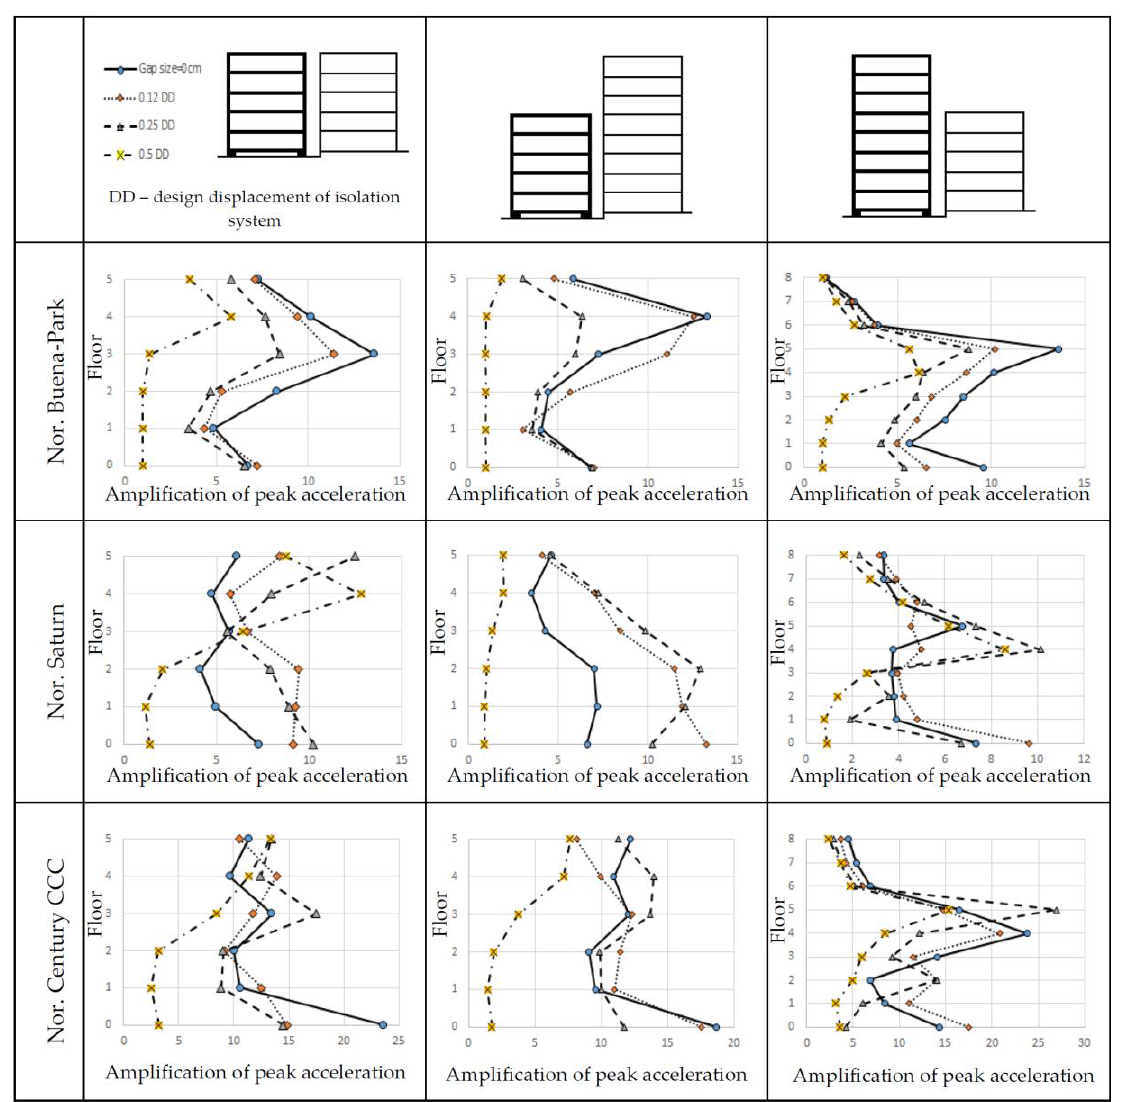
Figure 7. Acceleration amplification factors due to pounding for different gap sizes and various stories of the base-isolated building during the Northridge earthquake (stations: Buena-Park, Saturn Street School, and Century CCC).